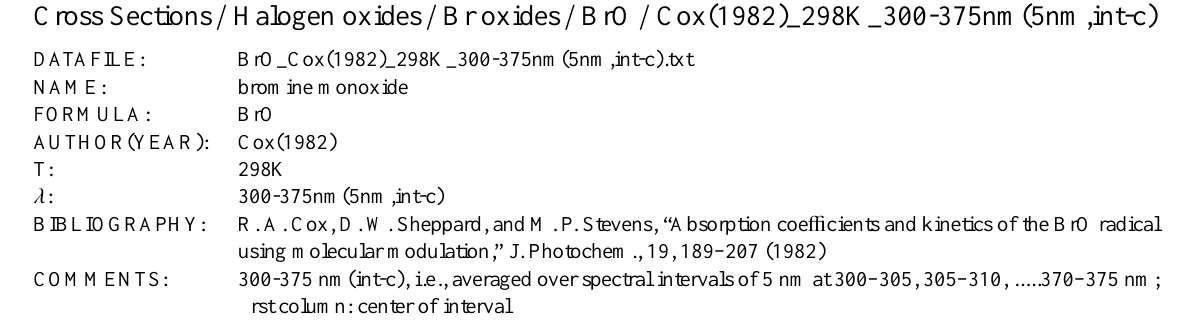
Table 2. Example for metadata associated with a cross section data set. The corresponding data file is shown in Table 3. Cross Sections / Halogen oxides / Br oxides / BrO / Cox(1982)_298K_300-375nm(5nm,int-c)